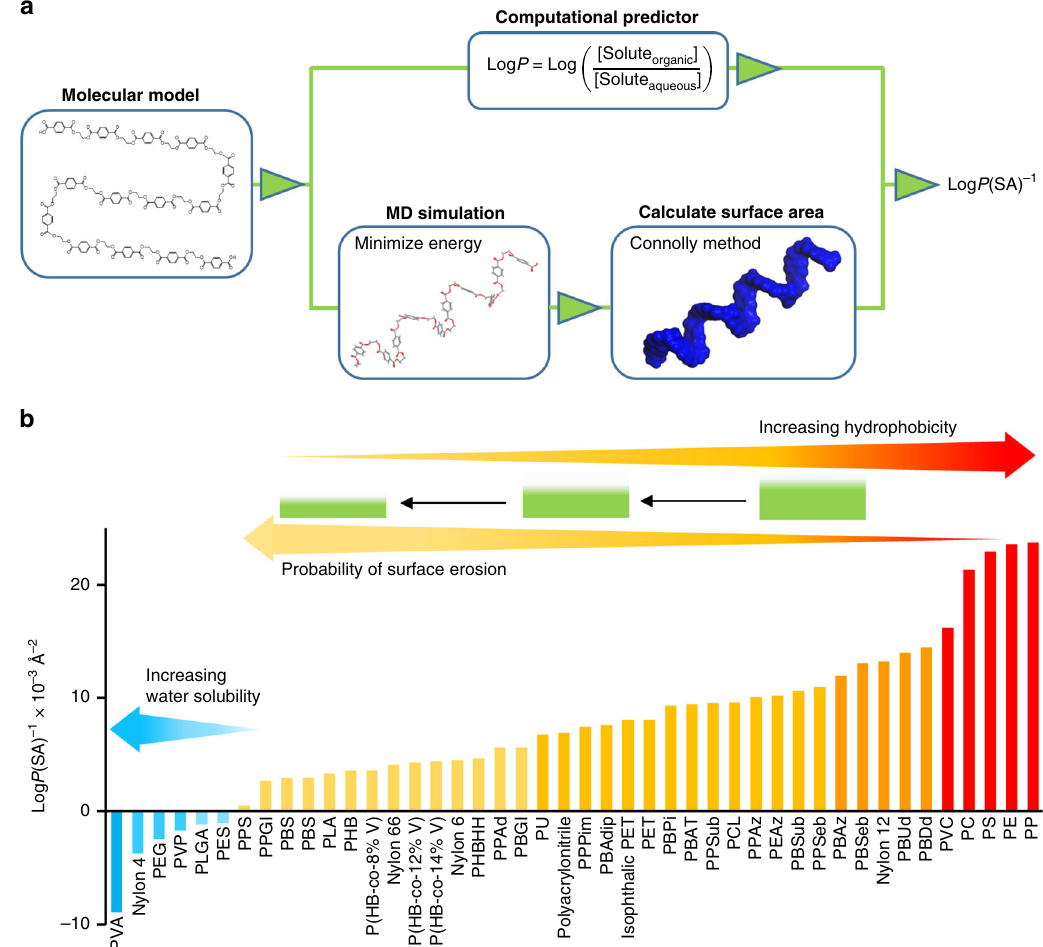
Fig. 1 Plastics cover a wide range of hydrophobicity. a Flow chart for calculating hydrophobicity, b range of Log P (SA) − 1 values for various